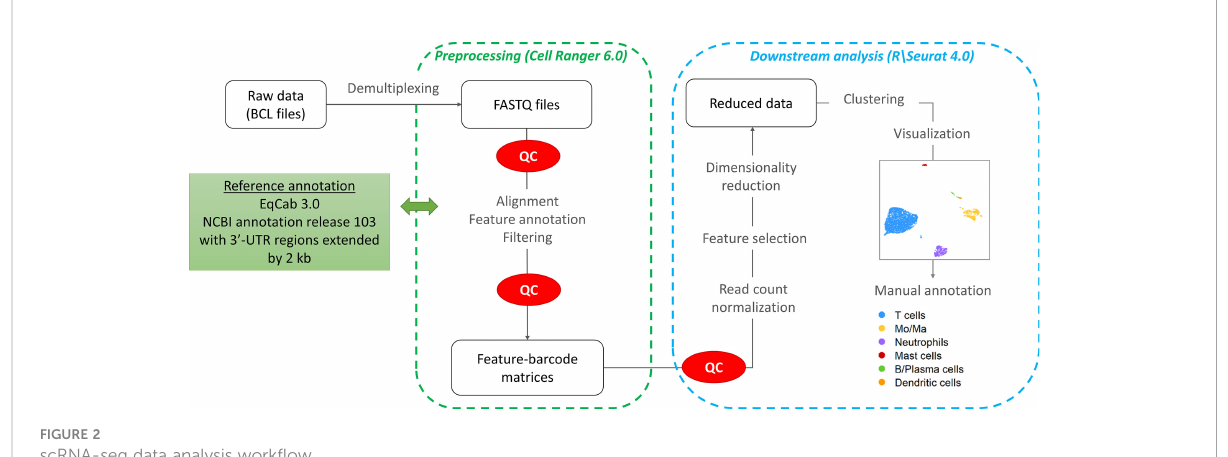
FIGURE 2 scRNA-seq data analysis work fl